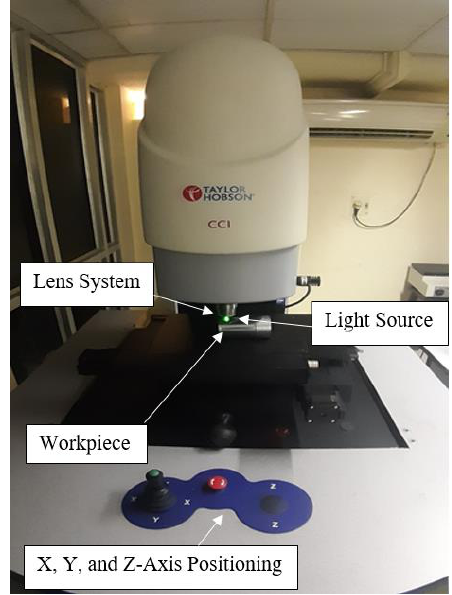
Figure 9. Workpiece placed under CCI for measuring surface roughness .